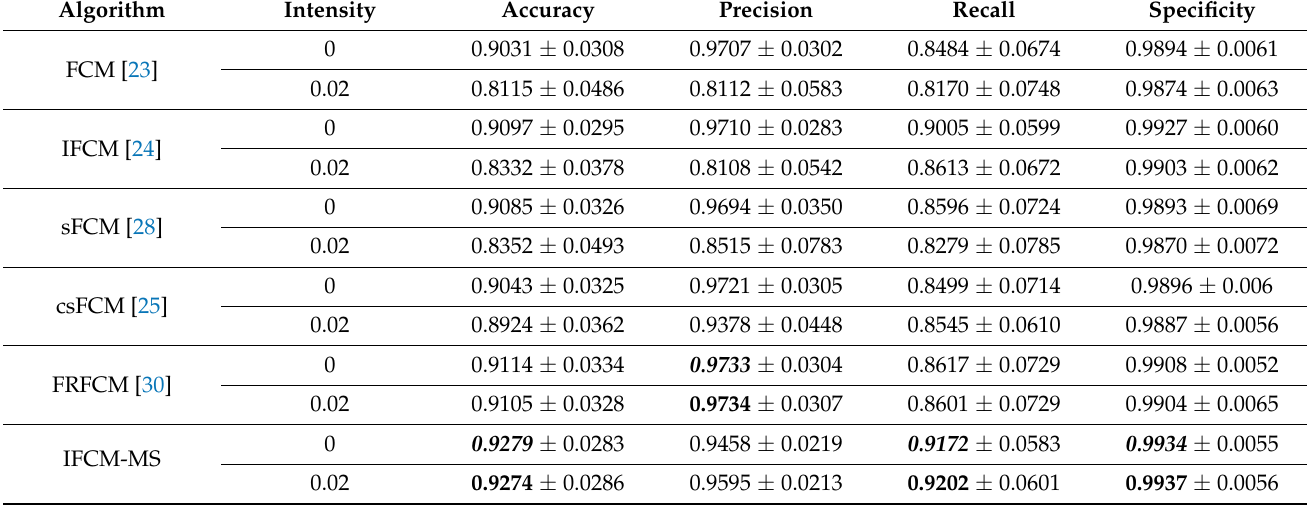
Table 3. Average values of the comparisons and the IFCM-MS (mean ± standard deviation). sFCM: spatial fuzzy C-means clustering algorithm, csFCM: conditional spatial fuzzy C-means clustering algorithm and FRFCM: FCM algorithm based on membership function filtering.